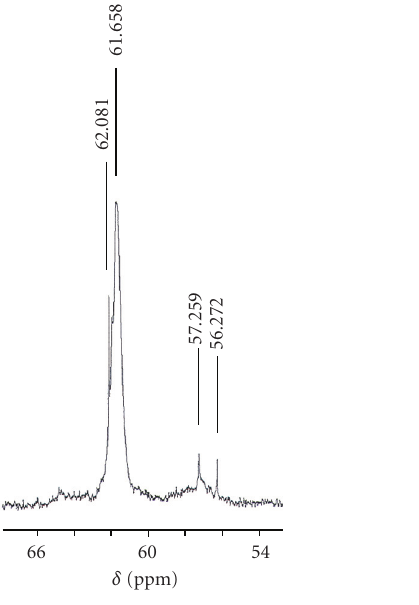
Figure 2: 13 C-NMR spectrum of poly(DEDPM) in the region of methine carbon.